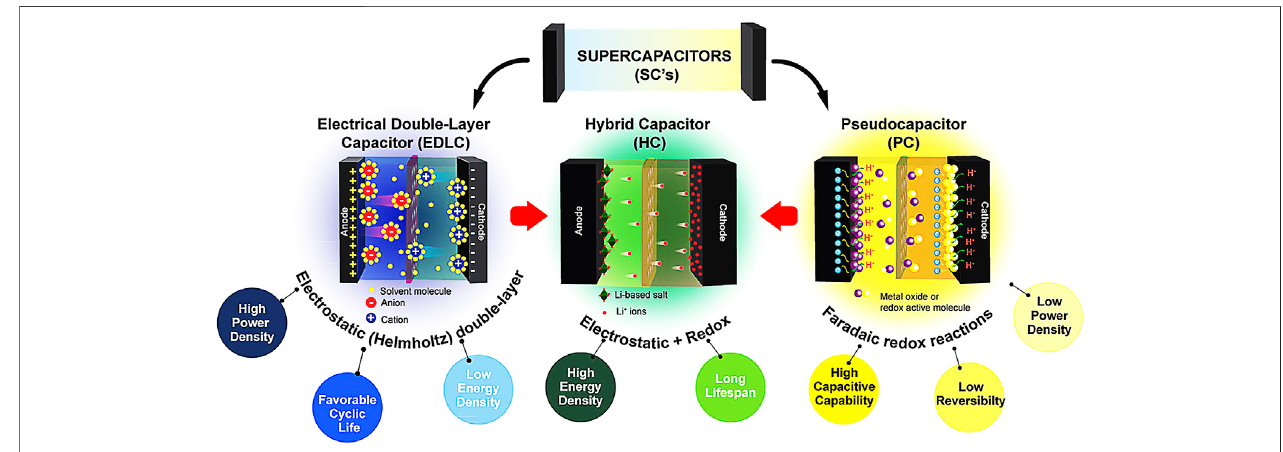
FIGURE 2 | The characteristics of conventional supercapacitors (SCs) like electrical double-layer capacitors (EDLCs), pseudocapacitors, and hybrid capacitors (HCs).